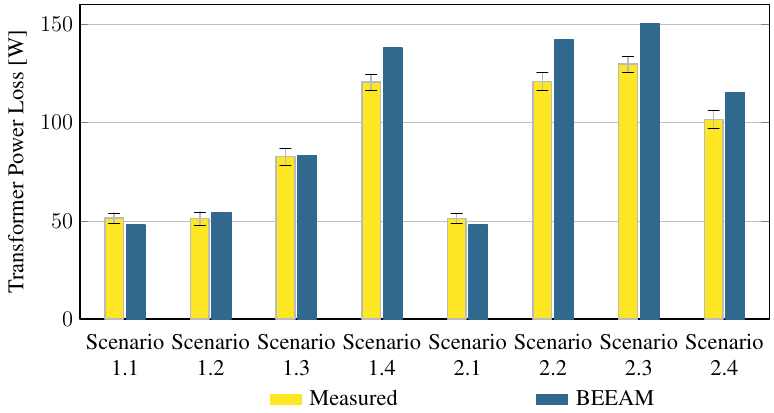
Figure A14. Predicted versus measured transformer loss, Scenarios 1 and